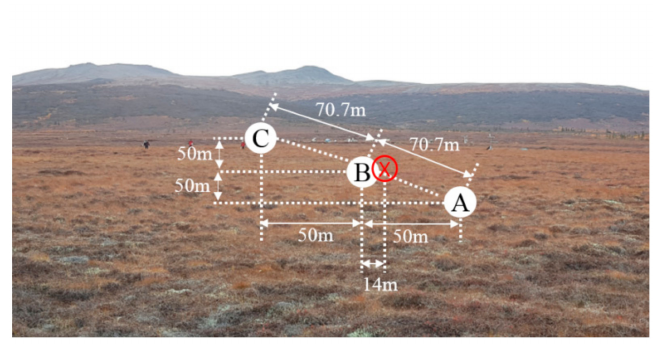
Figure 2. Locations of the soil temperature measurement sensors of the test